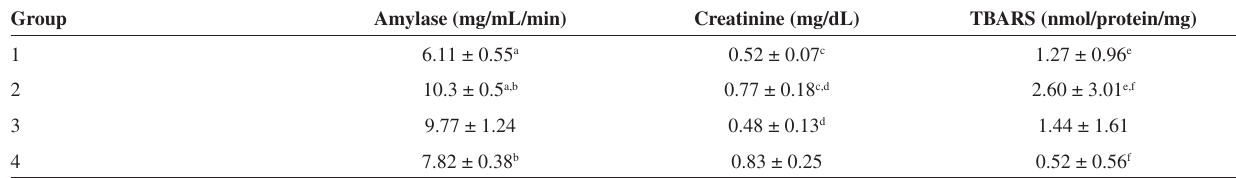
Table 1 - Amylase and creatinine serum levels and TBARS pancreatic tissue expressed as mean±standard deviation. Group Amylase